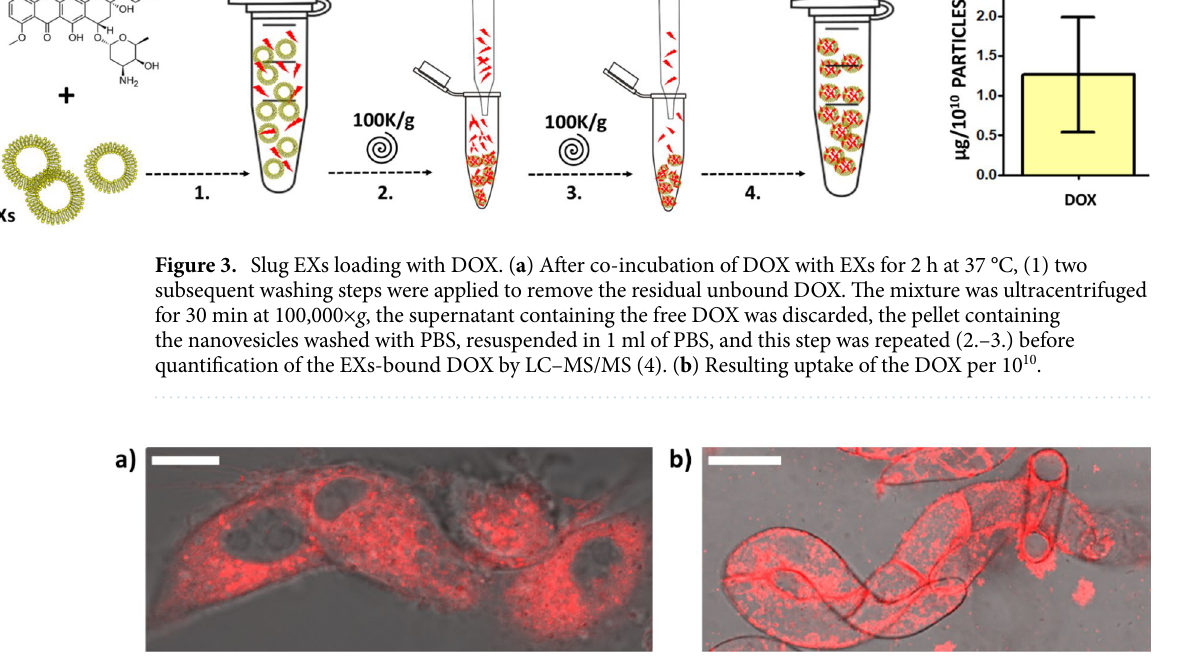
Figure 4. Slug EXs cell uptake assays. ( a ) Laser scanning confocal microscopy analysis of the U87 human glioblastoma cells after the BODIPY TR Ceramide stained EXs uptake assay. Scale bar = 10 µm. ( b ) Confocal microscopy analysis of the BY-2 plant cells after the EXs uptake assay. Scale bar = 50